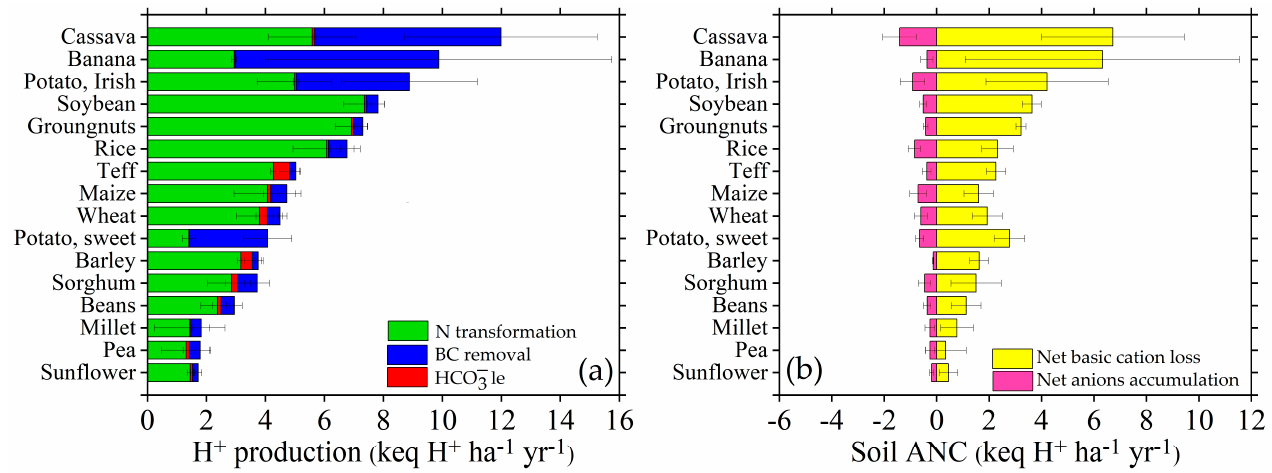
Figure 2. Variation of soil acidification (H + ) in different cropping systems ( a ) and soil H + production and absorption by net basic cation loss and net anion accumulation ( b ) in different cropping systems.